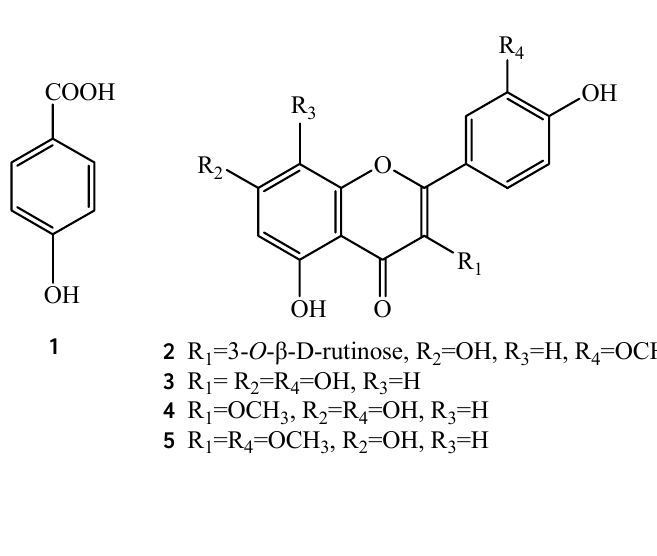
Figure 4. The structures of compounds 1 -